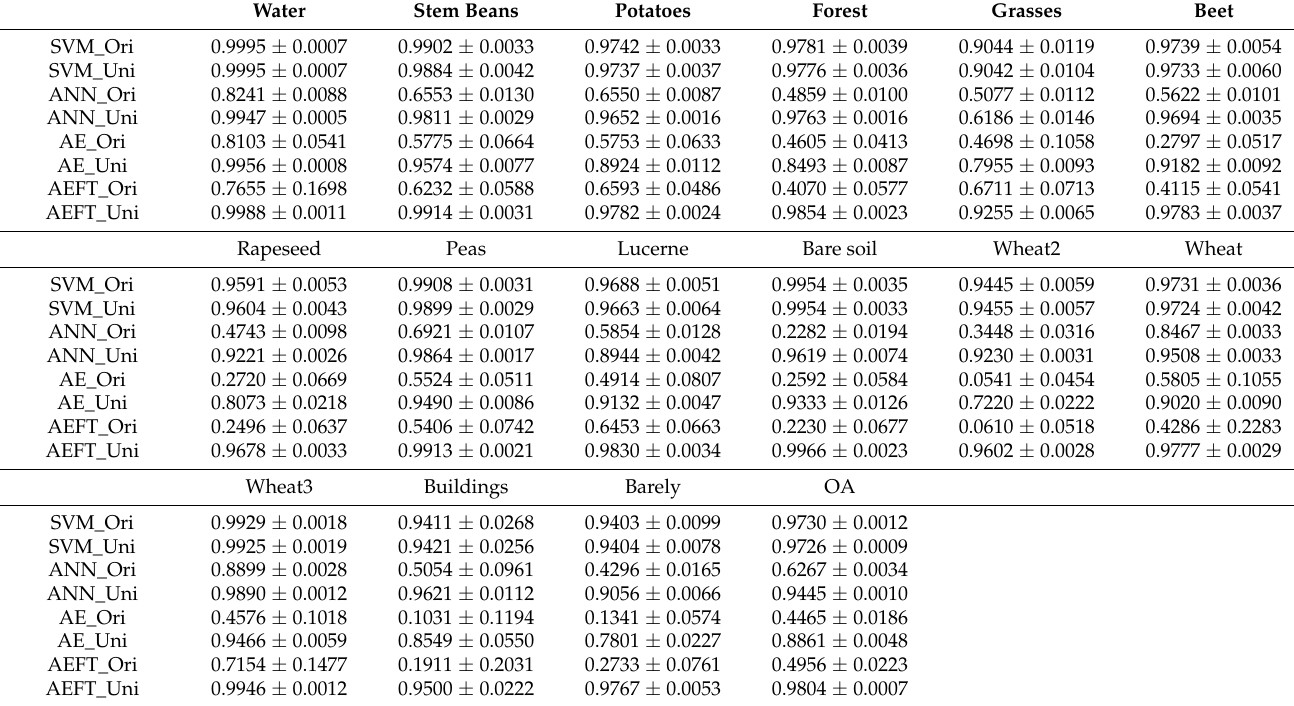
Table 8. Objective evaluation indicators of four classifiers on the normalized parameters and the original parameters of Touzi decomposition for Flevoland